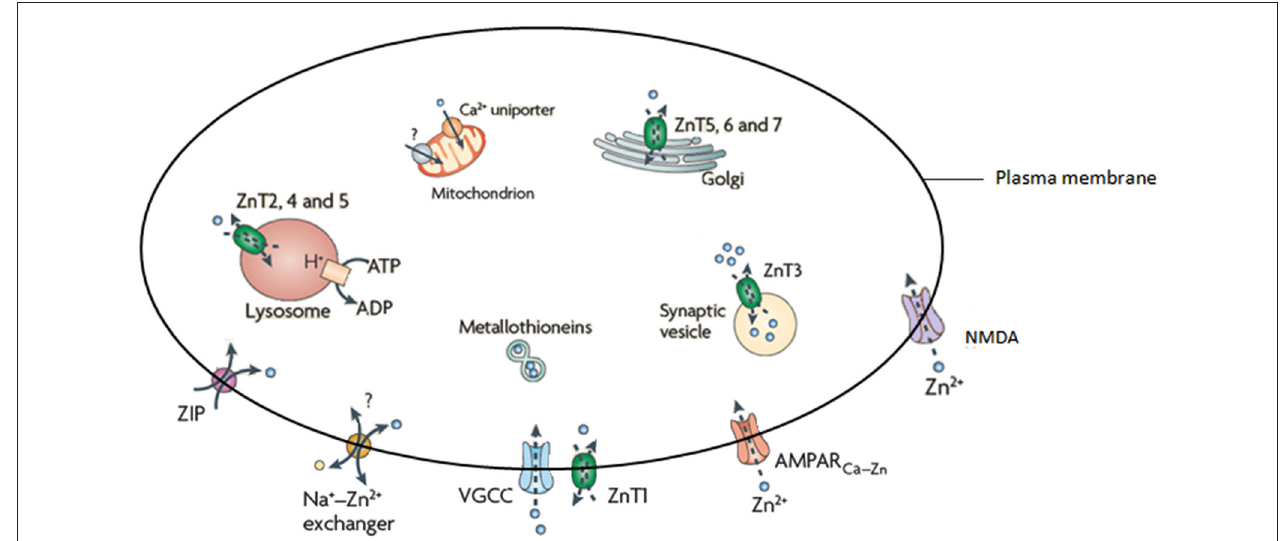
FIGURE 1 | Illustration of the proteins responsible for the homeostasis of Zn. Adapted from Sensi et al. (2009).